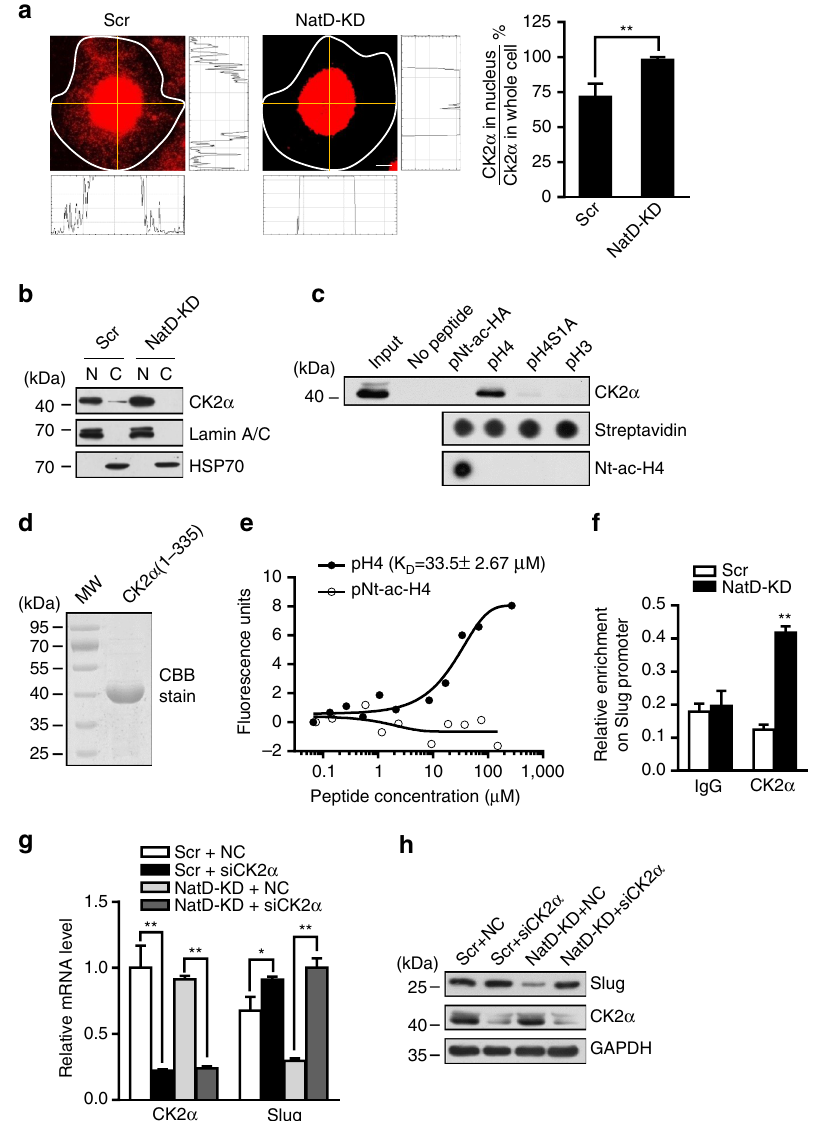
Fig. 7 Downregulation of Nt-acetylation of histone H4 facilitates nuclear accumulation of CK2 α and its binding to histone H4 in lung cancer cells. a Representative confocal scanning images of CK2 α localization in Scr and H1299 cells ( left panel ). The staining intensity of CK2 α was quanti fi ed by software ImageJ from NIH ( right diagram ). Scale bars , 5 μ m. Results are shown as mean ± s.d. from more than 30 cells from three independent experiments; two- tailed Student ’ s t -test, ** P < 0.01 compared with the Scr control. b Western blot analysis of CK2 α distribution in scrambled and NatD-KD H1299 cells with indicated antibodies. N nucleus, C cytoplasm. c Peptide pulldown assay to detect the interaction between H4 (1 – 31) or H3 (1 – 20) peptide (pNt-ac-H4, pH4, pH4S1A, or pH3) and CK2 α in H1299 cell nuclear extracts ( top panel ). Equal peptide biotinylated on C terminus is shown by dot blot analysis with streptavidin ( middle panel ). Nt-ac-H4 was con fi rmed by dot blot analysis with anti-Nt-ac-H4 antibody ( bottom panel ). d SDS-PAGE analysis of puri fi ed recombinant CK2 α (1 – 335) from E. coli stained by Coomassie brilliant blue (CBB). MW: protein molecular weight markers. e MST assay to identify direct interactions between CK2 α (1 – 335) and H4 or Nt-ac-H4 peptide. The dissociation constant ( K D ) between CK2 α (1 – 335) and H4 peptide is 33.5 ± 2.67 μΜ . f ChIP analysis of the enrichment of CK2 α on the Slug promoter in Scr and NatD-KD H1299 cells. IgG served as a negative control. Results are shown as mean ± s.d. from three independent experiments; two-tailed Student ’ s t -test, ** P < 0.01 compared with the indicated control. g Quantitative real-time PCR analysis of mRNA levels of CK2 α and Slug normalized to GAPDH in Scr and NatD-KD H1299 cells in the absence or presence of siRNA to CK2 α . NC, siRNA mimics negative control. Data are mean ± s.d. of three independent experiments; Student ’ s t -test, * P < 0.05, ** P < 0.01 compared with the indicated control. h Western blot analysis of indicated proteins from Scr and NatD-KD H1299 cells in the absence or presence of siRNA to CK2 α . GAPDH served as